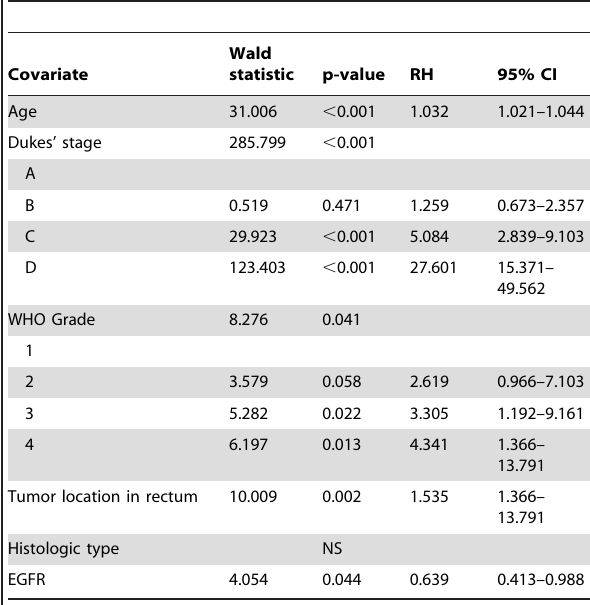
Table 4. Cox multivariate regression analysis of prognostic factors in 520 colorectal cancer